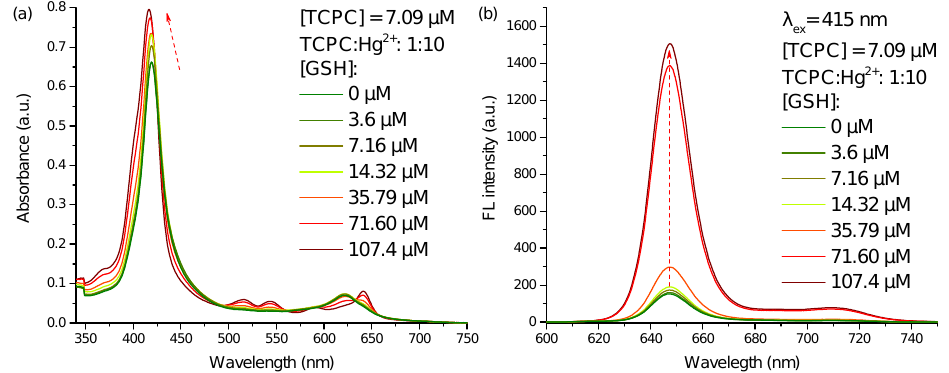
Figure 4. Absorbance ( a ) and fluorescence ( λ ex = 415 nm) ( b ) spectra of TCPC-Hg 2+ complex aqueous solutions (ratio 1:10) at pH 7.4 with different concentrations of